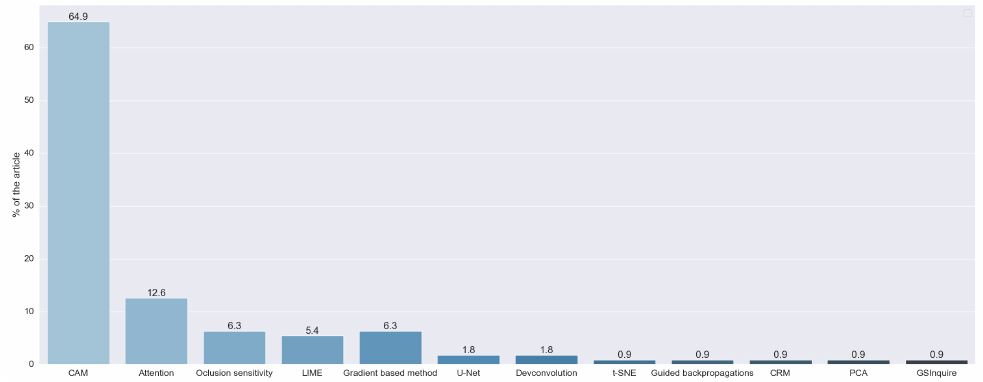
Figure 10. XAI techniques, obtained with RQ5. Vertical axis indicates the percentage of articles for each